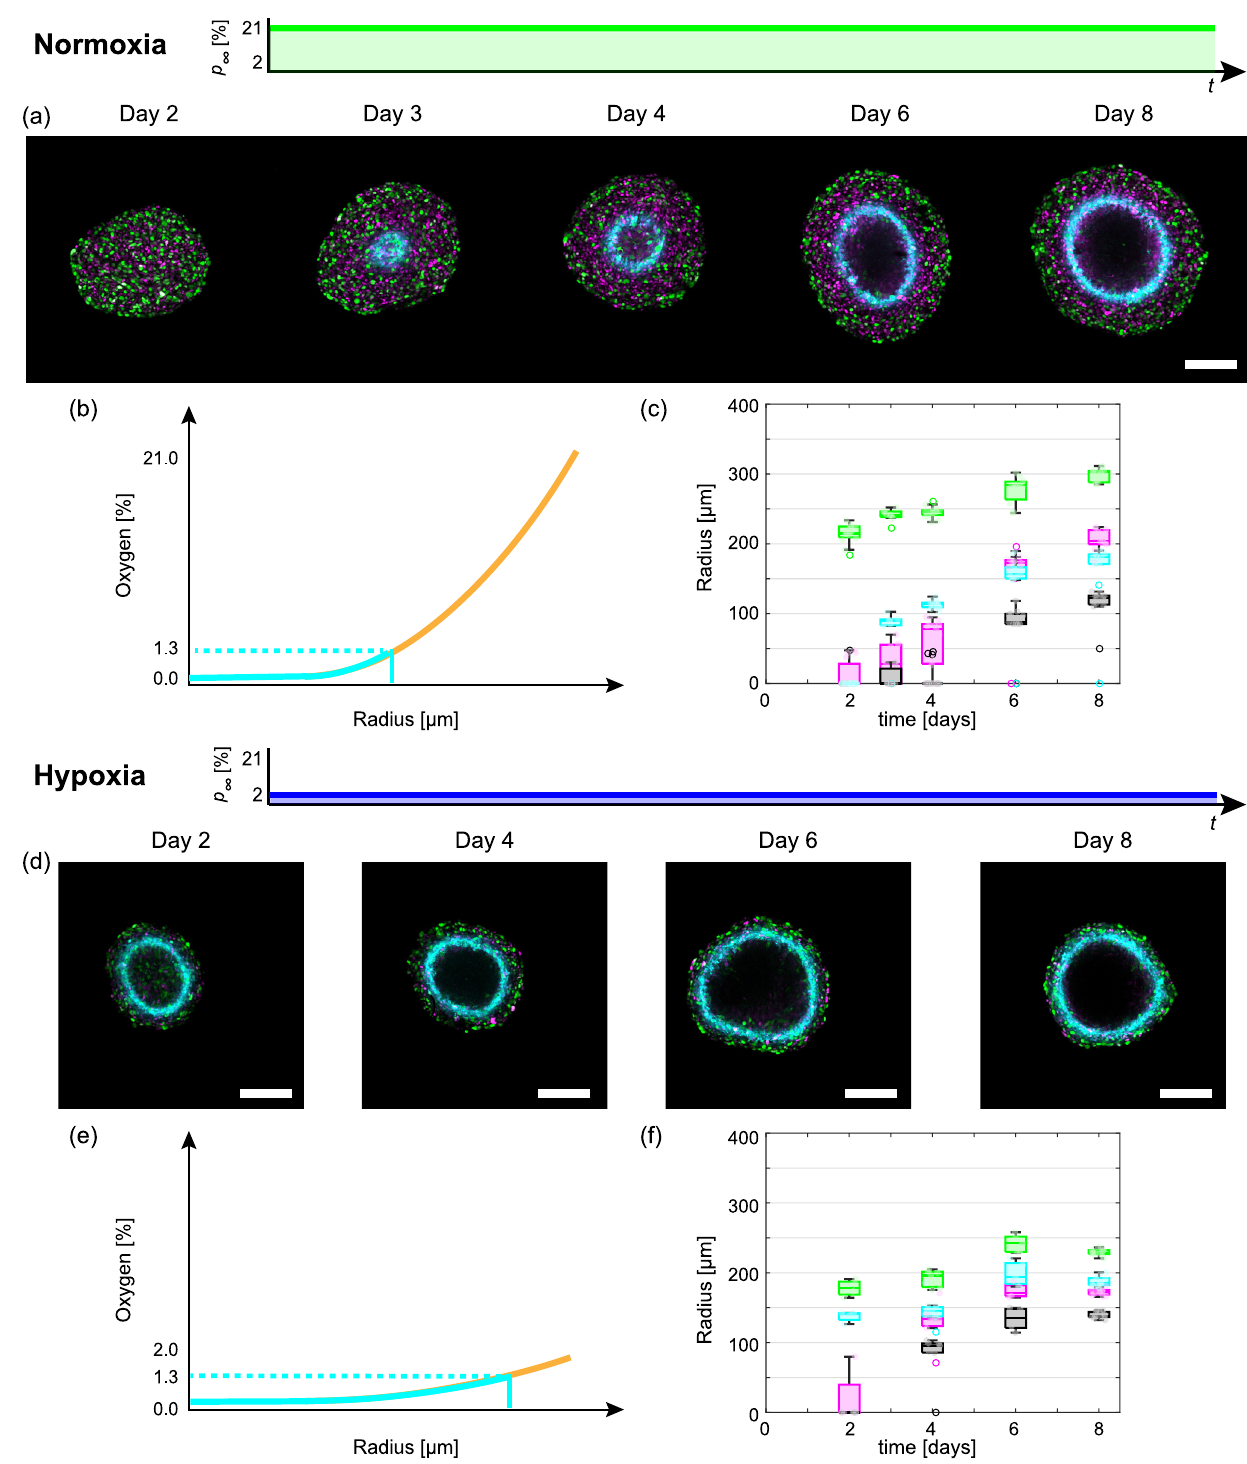
Fig 2. Tumour spheroid growth in normoxia and hypoxia. (a,d) Experimental images of the equatorial plane of FUCCI-transduced WM983b spheroids grown in (a) normoxia (21% oxygen) and (d) hypoxia (2% oxygen). (a) Images shown on Day 2, 3, 4, 6, and 8 after seeding. (d) Images shown on Day 2, 4, 6, and 8 after seeding. Scale bars are 200 μ m. (b,e) Schematics for oxygen partial pressure within spheroids for (b) normoxia and (e) hypoxia, where the solid blue/orange lines represent the oxygen partial pressure inside/outside of the hypoxic region and the hypoxic threshold is determined by the presence pimonidazole staining (blue-dashed). (c,f) Time evolution of R o ( t ) (green), R i ( t ) (magenta), R n ( t ) (black), and R p ( t ) (cyan) corresponding to schematic in Fig 1E for spheroids grown in (c) normoxia, and (f) hypoxia. Note that each spheroid measurement is an end-point measurement. For additional experimental images for each condition with the boundaries of the proliferating, inhibited and hypoxic regions overlayed see Text A.2 of S1 File.